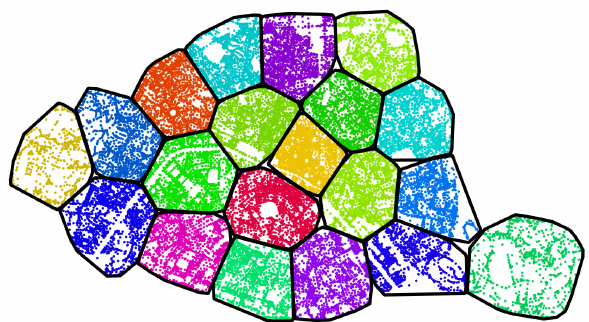
Figure 16: Clustering road axis centroid with K-Means, K=20, (black segments are convex hull).